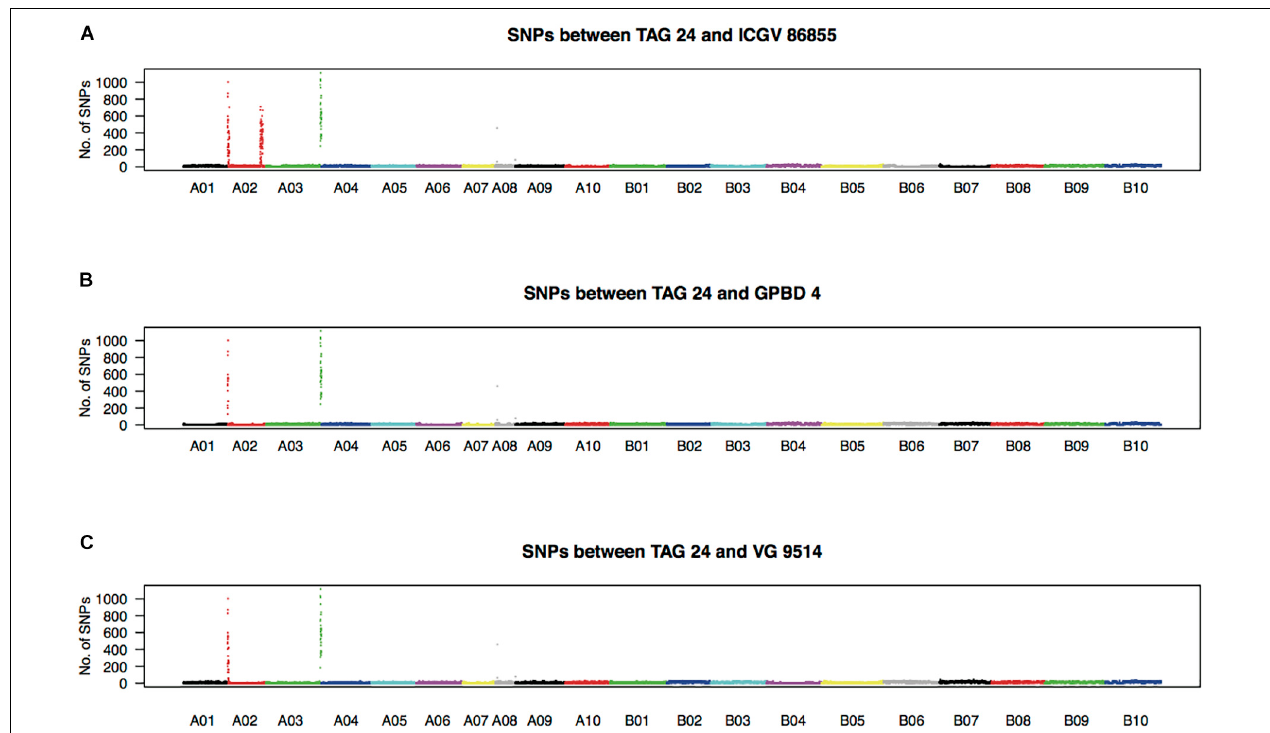
FIGURE 2 | Density of SNPs in resistant lines with respect to TAG 24. Numbers of SNPs every 100-kb length over the genome between TAG 24 and either ICGV 86855 (A) , GPBD 4 (B) , or VG 9514 (C) are plotted.